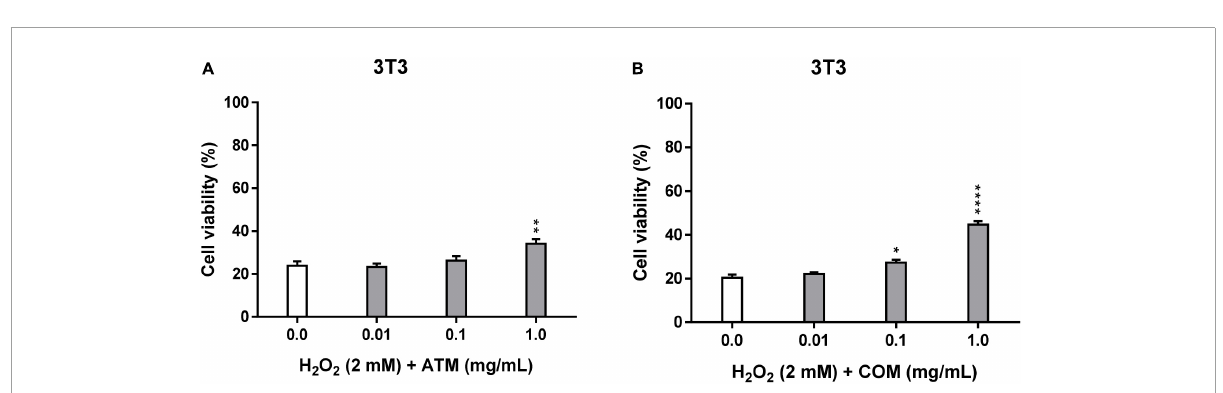
FIGURE3 Cellular repair activity of ATM (A) and COM (B) in 3T3 cell line for 2 mM H 2 O 2 during 2.5 h by MTT assay and expressed as a percentage of cell viability with respect to untreated cells control. H 2 O 2 cell viability was used as a positive control. Results are expressed as mean ± standard error of n = 3. A two-way analysis of variance (ANOVA) and a Bonferroni post hoc assay have been performed. Statistical differences were considered as follows: * p ≤ 0.05, ** p ≤ 0.01, and **** p ≤ 0.0001 comparison with positive